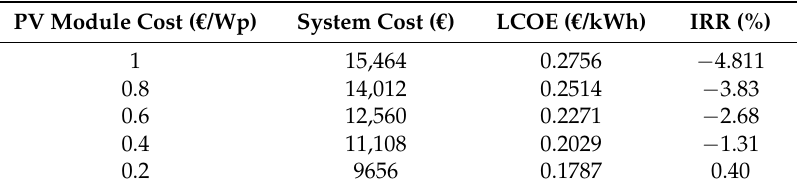
Table 4. Comparison of levelised cost of energy (LCOE) and internal rate of return (IRR) based on a recovery factor at 10% interest, for the 5 kW